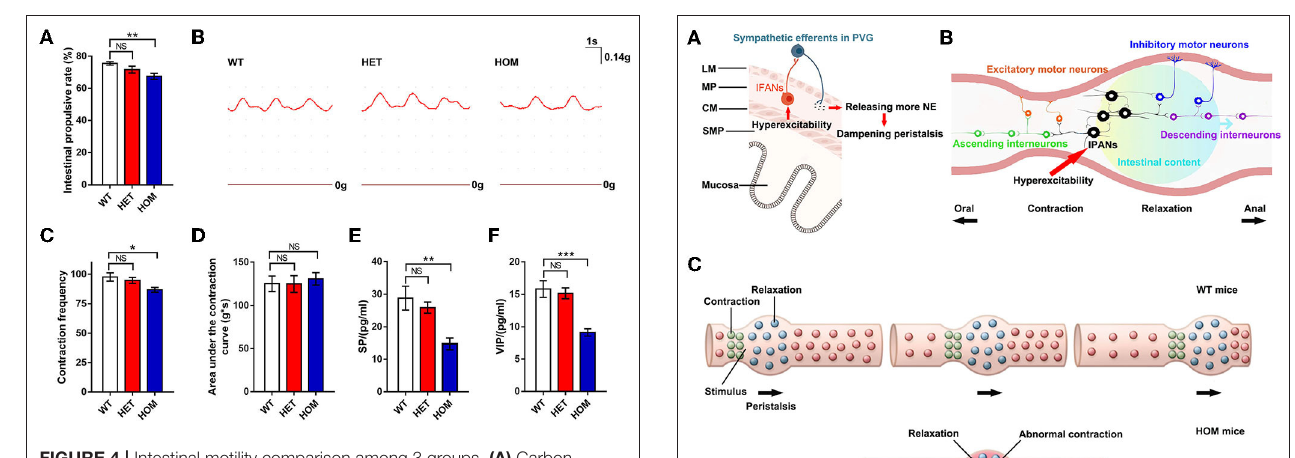
FIGURE 4 | Intestinal motility comparison among 3 groups. (A) Carbon powder propelling test. Twenty minutes after gavage with a charcoal meal, distances traveled by charcoal meal along the intestine in mice were measured and quantified as a percentage of distance traveled. (B) The traces of the intestinal segments contraction curves were recorded from a representative WT, HET, and HOM mouse, respectively. (C,D) The tonotransducer continuously recorded the number of contractions and calculated area under the contraction curve for 3min. (E,F) The concentrations of SP and VIP (tested by ELISA) were decreased in the intestinal tissues of Scn11a knock-in mice. Data were presented as the mean ± SEM. Significance was tested with one-way ANOVA followed by Dunnett’s multiple comparisons test. * p < 0.05, ** p < 0.01, *** p < 0.001 vs. WT mice. NS, no significance; WT, wild-type